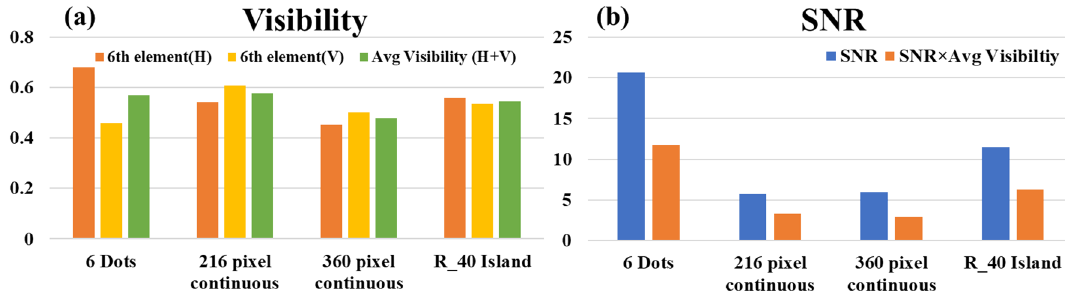
Figure 8. Comparative charts of ( a ) visibility and ( b ) SNR for I-COACH system’s with different system